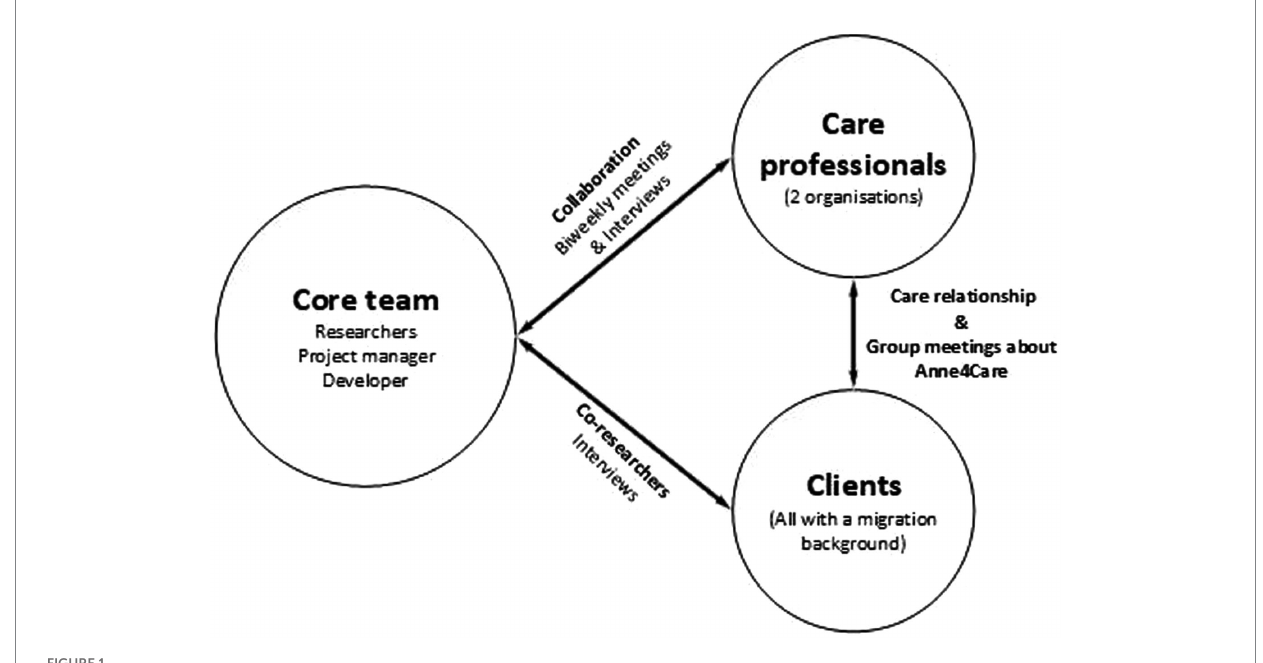
FIGURE 1 Overview of stakeholder groups and